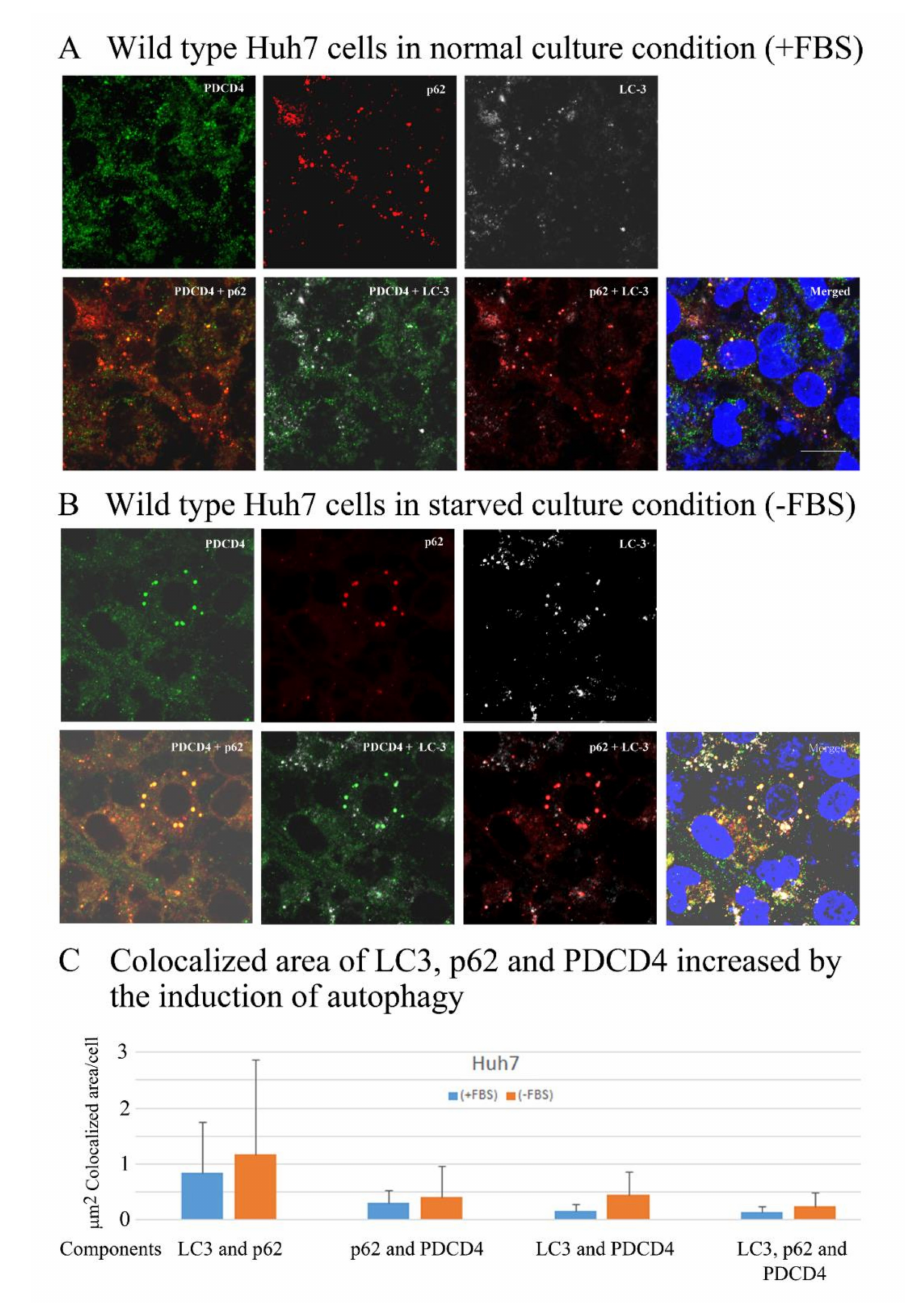
Figure 7. PDCD4, p62. and LC3 were colocalized, and the colocalization areas expanded under serum-deprived conditions in wild-type Huh7 cells. ( A , B ) A total of 1.5 × 10 5 cells were seeded onto a cover glass in 35-mm dishes and cultured until 70–80% confluency. The old medium was replaced with Dulbecco’s modified Eagle’s medium (DMEM) or DMEM + 10% FBS. The dishes were washed twice with DMEM before adding the new medium. Culture was continued for 4 h, and the cells were fixed with 4% paraformaldehyde. Immunostaining of the cells were performed as described in methods. Images were captured using an LSM-880 confocal microscope. The colocalization of PDCD4, p62, and LC3 in the presence (A) and absence (B) of FBS is shown. ( C ) A diagram of the colocalization areas of PDCD4, p62, and LC3 in wild-type Huh7 cells. Bar = 300 µ